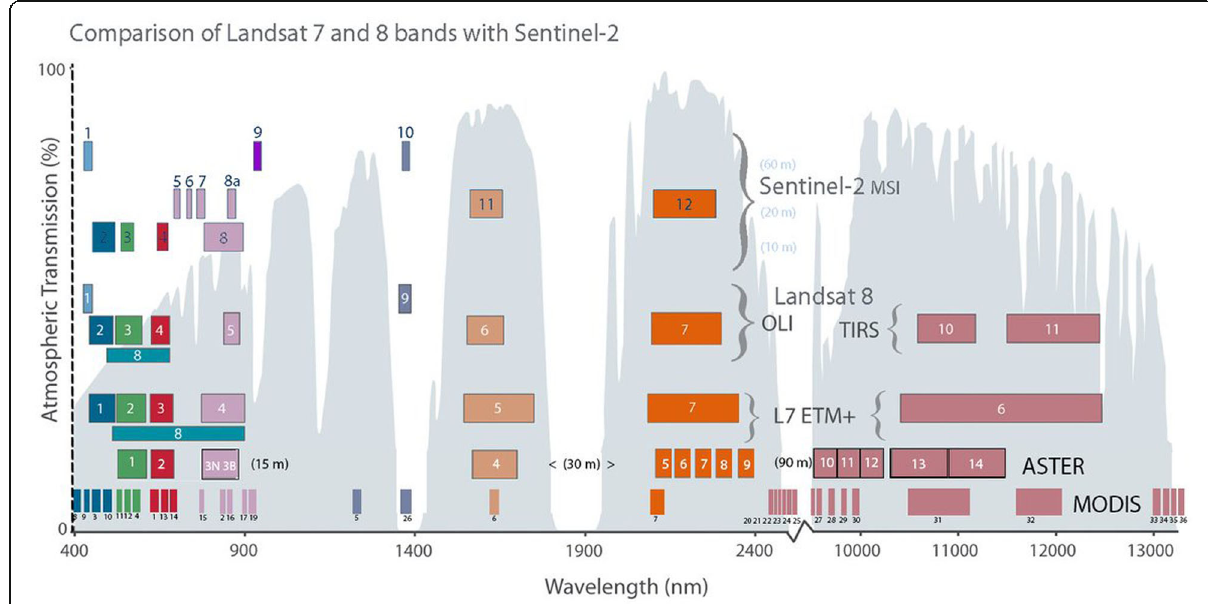
Fig. 4 Comparison of Landsat-7, Landsat-8, and Landsat-9 bands with Sentinel-2, ASTER, and MODIS bands. Band widths, wavelength locations, and spectral region: VIS — blue, green, and red, NIR — lavender; SWIR 1 — earth orange and SWIR — 2 brick red; rose-colored bands are TIR. The band numbers for MODIS bands ( Bottom Row 1 ) are shown in order of wavelength, in colors matching the bands: 8, 9, 3, 10 — blue; 11, 12, 4 — green; 1, 13, 14 — red; 15, 2, 16, 17, 19 — lavender; 5, 26 — light blue; 6 — earth orange; 7 — brick red; 20, 21, 22, 23, 24, 25, 27, 28, 29, 30, 31, 32, 33, 34, 35, 36 — rose. The narrow band 18 (931 – 941 nm) is not represented in this figure because it is within the wavelength range of band 19 (915 – 965 nm). Band 18 is located in the atmospheric water vapor absorption feature and contributes to the MODIS Precipitable Water Product. ASTER ’ s 14 bands ( Row 2 ) range in size from 15 to 90 m, as shown. Landsat-7 and Landsat-8 ( Rows 3 and 4 ) optical bands have 30 m pixels and thermal bands with 120 m (L-7) or 100 m (L-8). Sentinel-2 ( Top Row 5 ) has 13 optical bands at either 10 m, 20 m, or 60 m spatial resolution and no TIR bands. Figure from